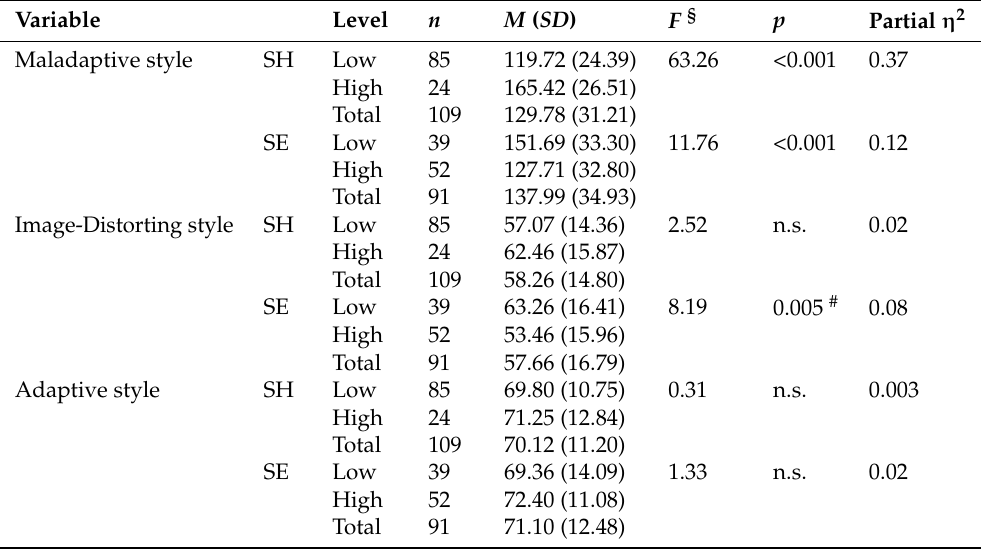
Table 8. Follow-up ANOVAs. Defense style scales by low and high Studyholism (SH) and Study Engagement (SE).